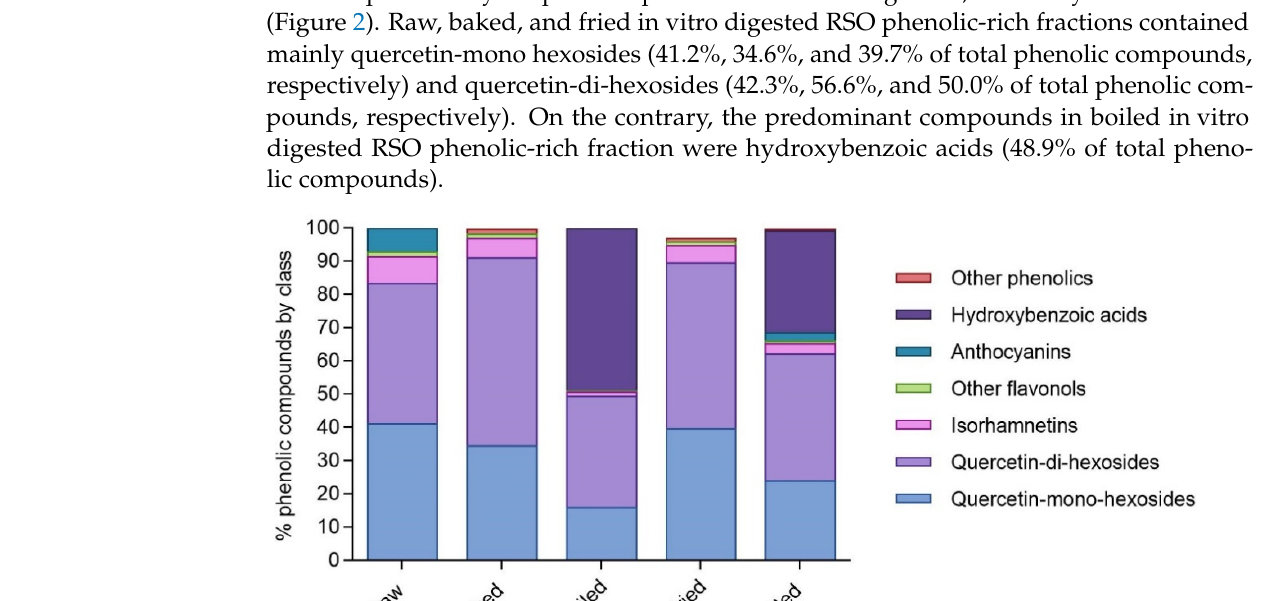
Figure 2. Percentage distribution of the main classes of phenolic compounds in raw and cooked in vitro digested red-skinned onion phenolic-rich fractions. The percentage values are referred to the total concentration of phenolic compounds identified in the raw and cooked in vitro digested red-skinned onion samples as reported in Table 2 and expressed as µ mol of compound/100 g of raw or cooked onion.